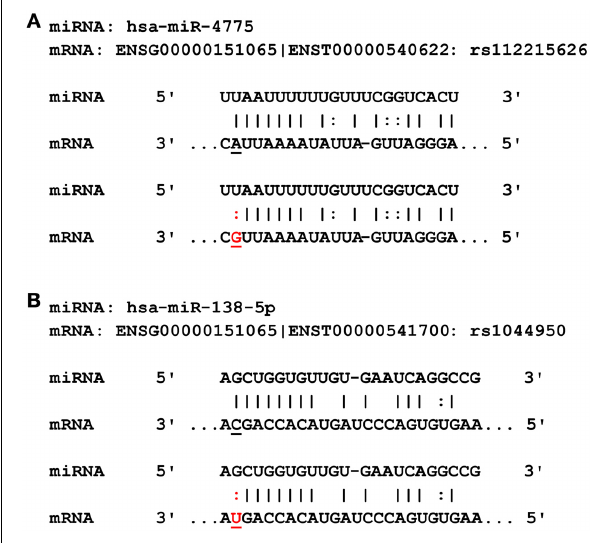
FIGURE 1 | Predicted miRNA binding sites in the DCP1B transcripts. (A) Rs112215626 is located in the seed region of hsa-miR-4775. The alternative (G) allele of rs112215626 (highlighted in red) may alter binding affinity of hsa-miR-4775 to the DCP1B 3 (cid:2) UTR and therefore alter protein levels. (B) Rs1044950 is located in the seed region of hsa-miR-138-5p. The alternative T allele of the rs1044950 (highlighted in red) may alter binding affinity of hsa-miR-138-5p to the DCP1B 3 (cid:2) UTR and subsequently alter protein levels.